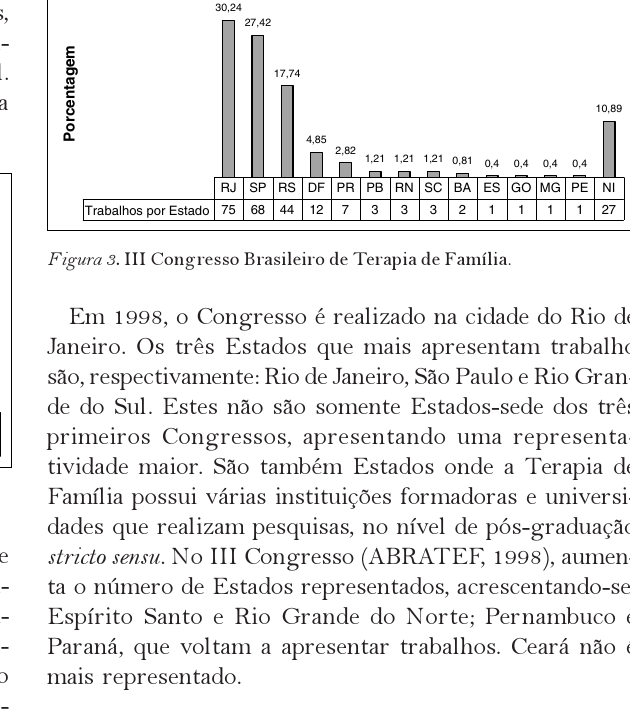
Figura IV V Congresso Brasileiro de Terapia de